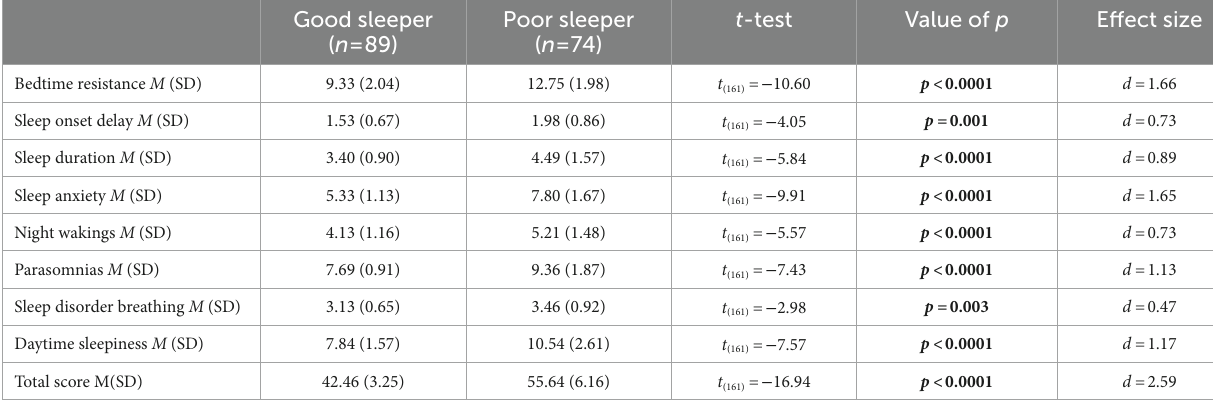
TABLE 2 Differences in CSHQ scales between poor and good sleepers.